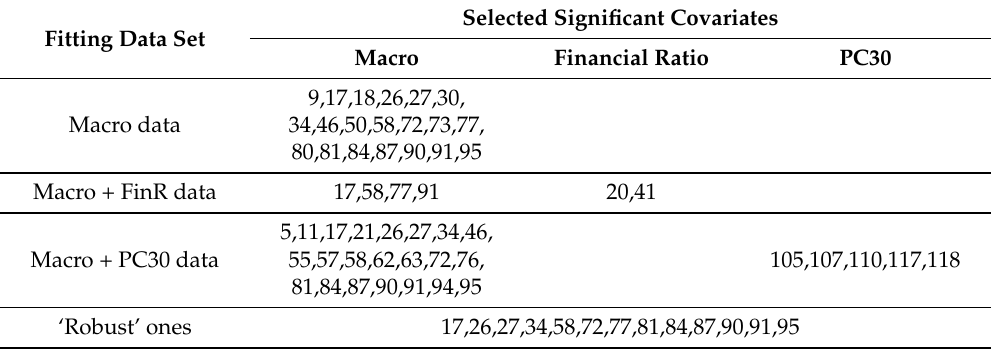
Table 6. Significant and Robust Covariates: